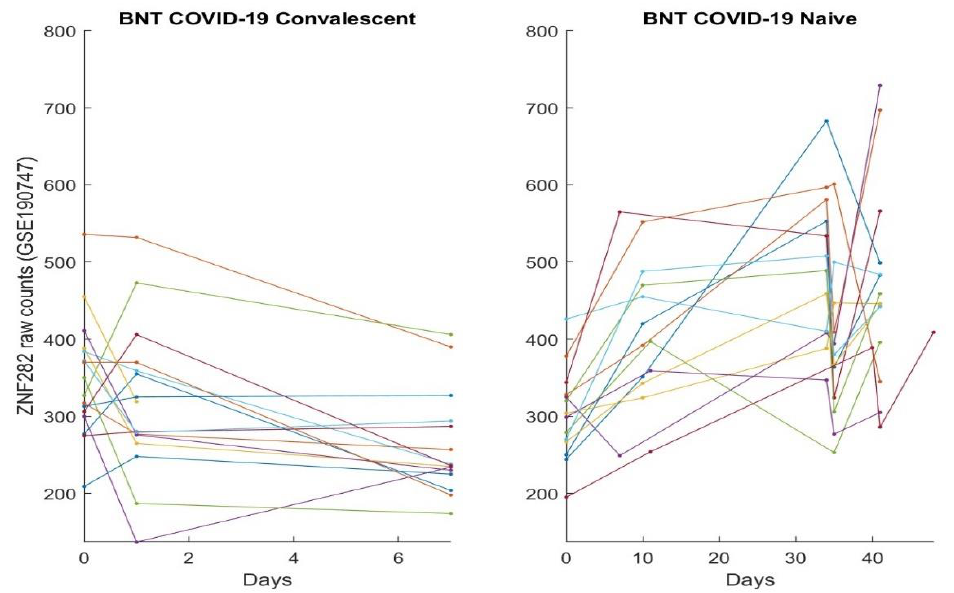
Figure 4. ZNF282 expression responses to BNT162b2 vaccines: The left panel is for COVID-19-recovered octogenarians; the right panel is for COVID-19-naïve individuals. Each color line corre- sponds to one patient’s records.